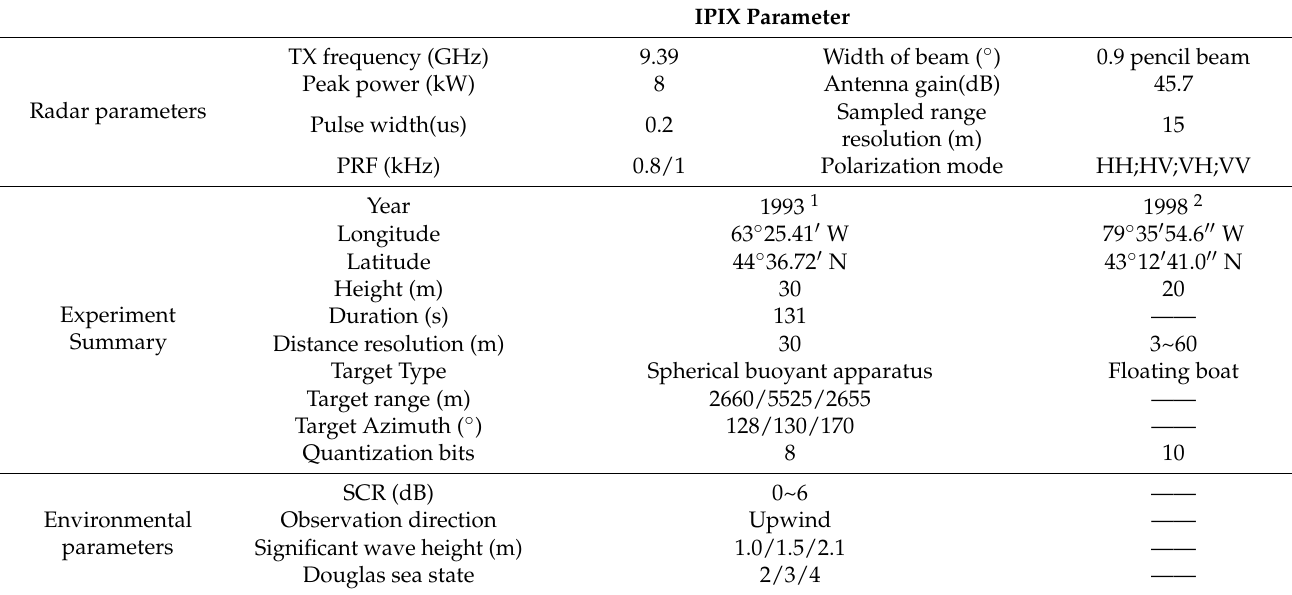
Table 3. IPIX radar and experimental